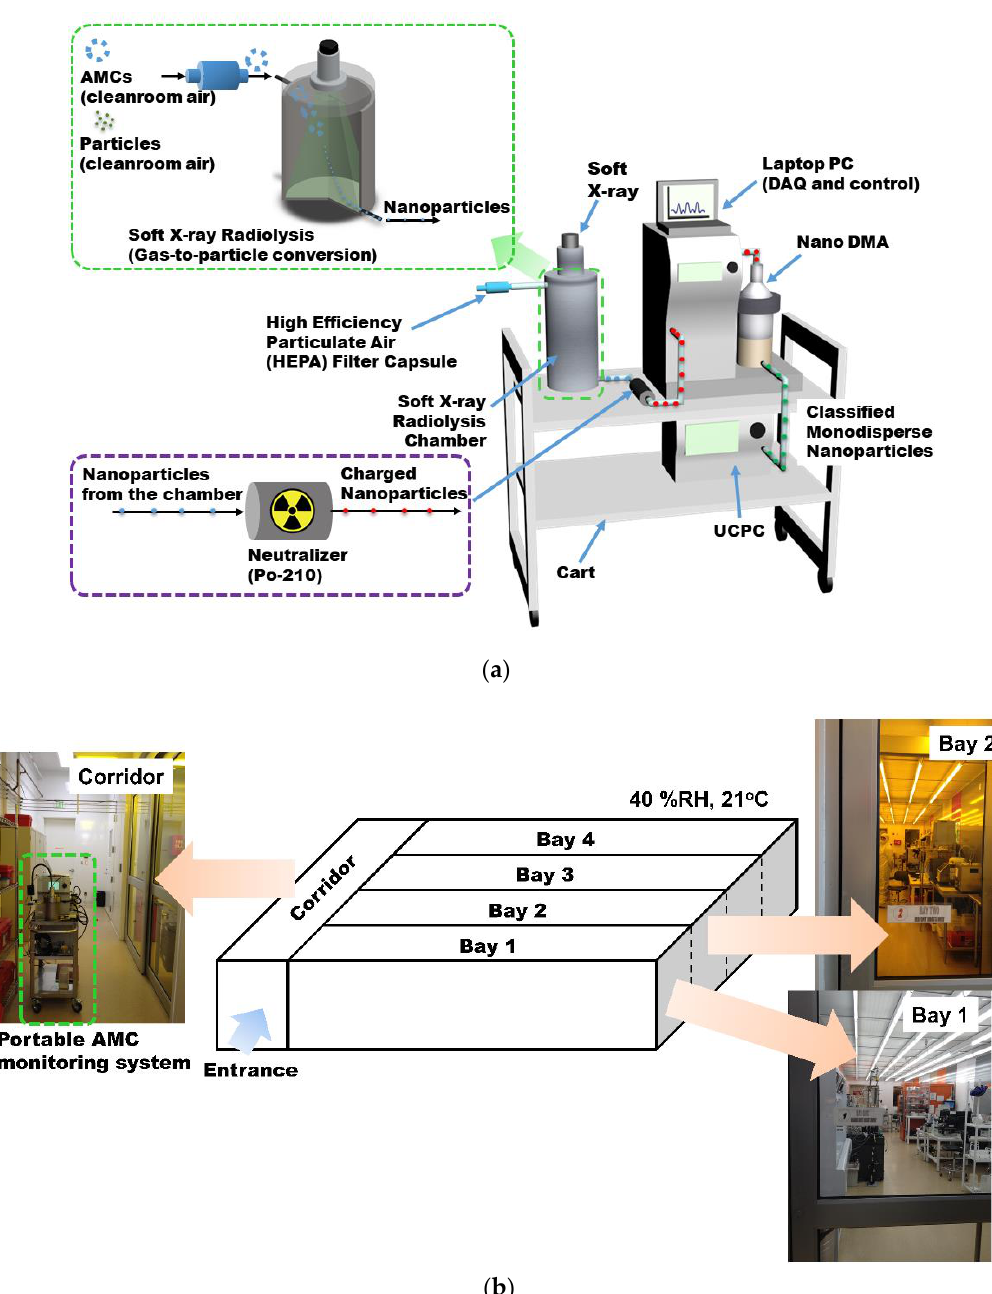
Figure 1. ( a ) Schematic diagram of the portable detector for airborne molecular contamination (AMC) deploying Soft X-ray Radiolysis, and ( b ) the configuration of the cleanroom at the University of Minnesota.